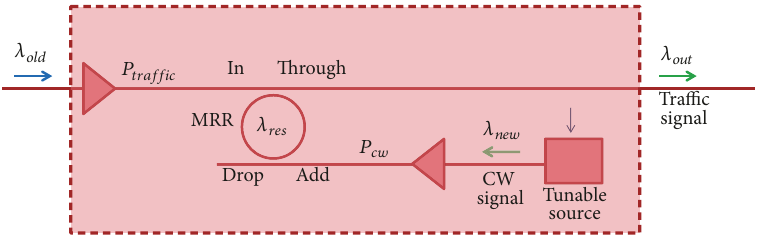
Figure 7: Possible implementation of the tunable all-optical wavelength converters (TAOWC) based on SOI microring resonators (MRRs).